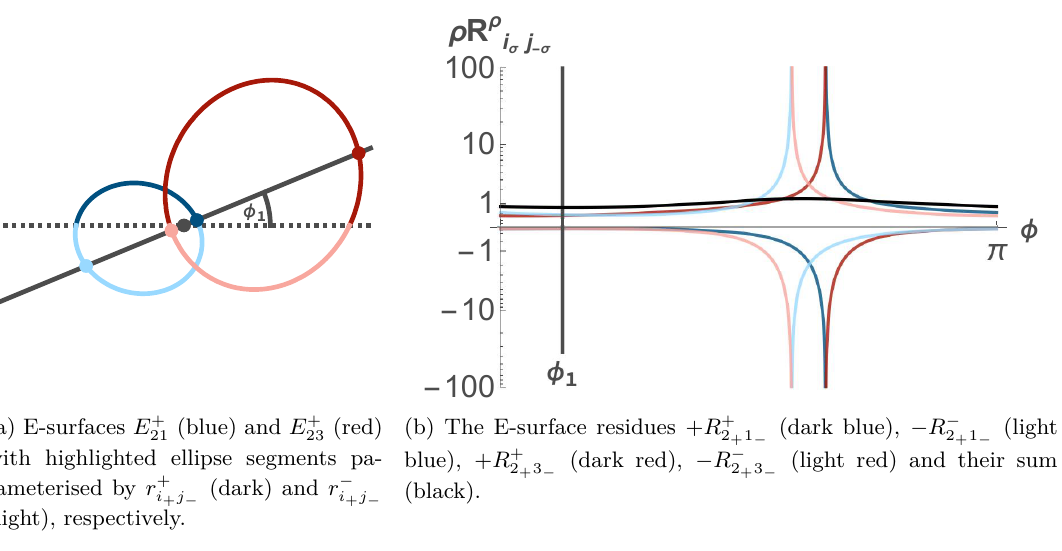
Figure 7. Local cancellations in the imaginary part of a scalar triangle according to eq. (3.32). The E-surfaces E + in two-dimensional spatial momentum space are shown in (a) and their corresponding ij residues ρR ρ in (b). They are parameterised by the radial solutions r ρ i + j − the E-surfaces are scanned at two points simultaneously. Both intersections, where r + = r − , correspond to spurious, locally cancelling poles in the residues + R + r − 21 23 and − R − , respectively. In fact, placing the origin within the ellipses’ overlap ensures − R − 2 + 1 − 2 + 3 − local cancellations and avoids the introduction of integrable singularities (cf. figure